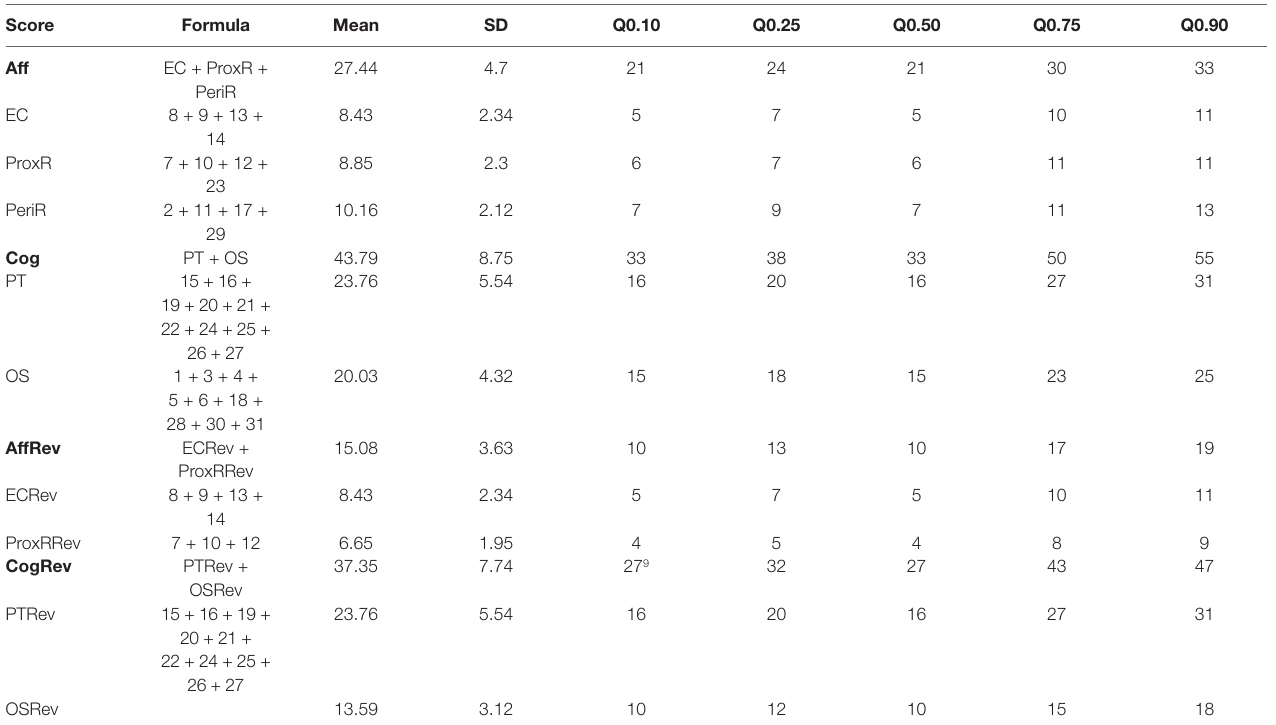
TABLE 1 | Mean, standard deviations, and quantiles of the different scores with their formulae. Score